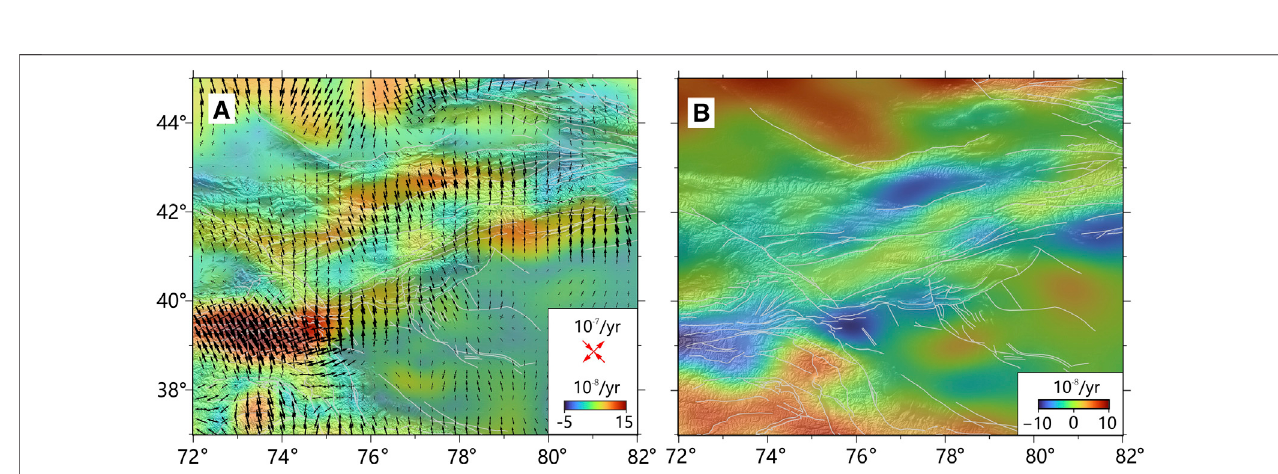
FIGURE 10 | Continuum deformation fi eld of Tianshan derived from horizontal velocities. (A) Strain rates. Maximum shear strain rate is shown in background color and principal strain rates are shown as vector pairs. (B) Dilatation rate.